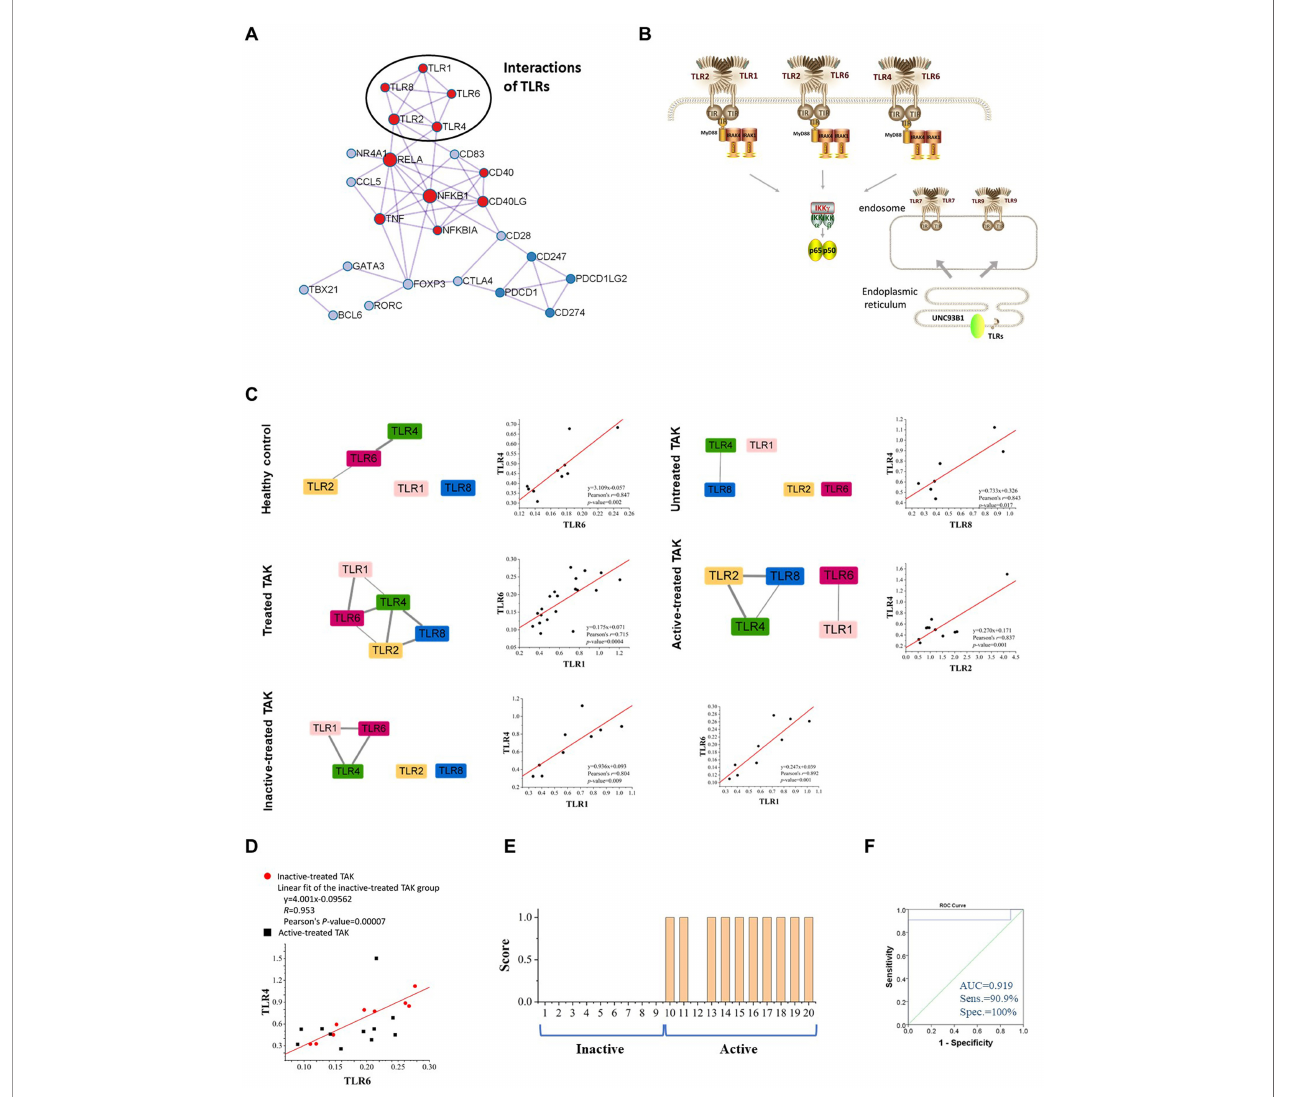
FIGURE 6 | TLR-expression signature serves as a biomarker of different disease and treatment stages in TAK. (A) The protein-protein interaction network using the molecular complex detection (MCODE) algorithm performed by Metascape database, indicating the tight relationship among TLRs. (B) The schematic drawing of the interaction or cross-talk between TLRs. (C) The TLR-expression signature of different disease and treatment stages of TAK and scatter plots, and the different co- expressions might mean different functional relationships between TLRs at different stages. (D, E) The regression equation relating the TLR6 mRNA level to the TLR4 mRNA level serves as a biomarker of active disease in treated TAK. The scatter plots (D) , the linear regression (D) , the score for the disease activity assessment of each treated TAK patient (E) , and the receiver operating characteristic curve (ROC) (F) of the TLR4-TLR6 pair. TAK, Takayasu ’ s